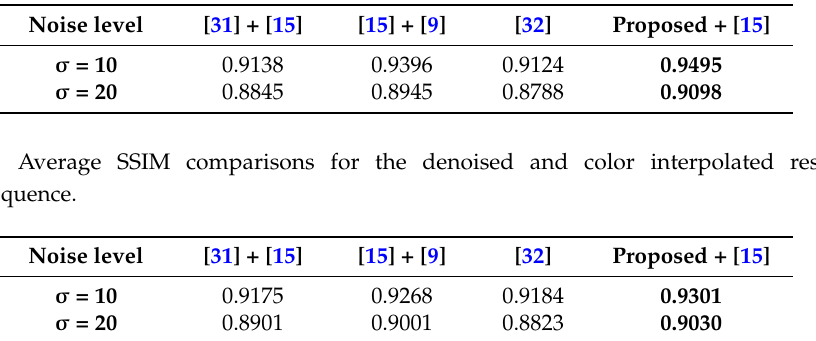
Average SSIM comparisons for the denoised and color interpolated results of Moving train sequence.